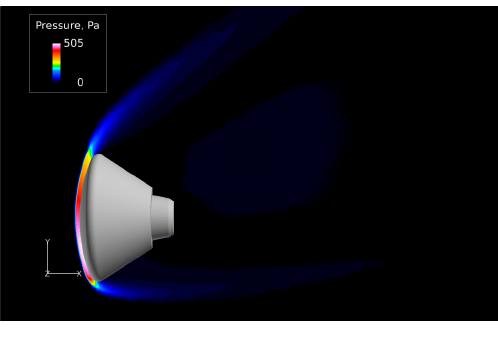
Figure 9. Pressure distributions around the ESA ARD at an altitude of 85 km ( x - y plane).